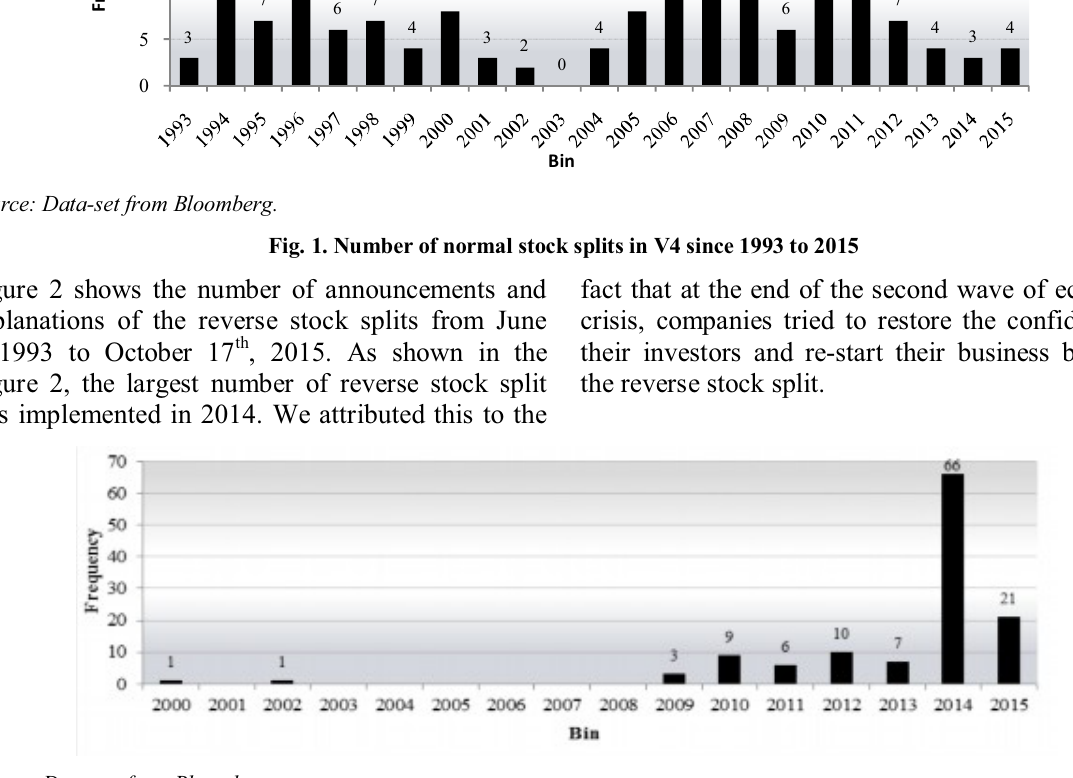
Fig. 2. Number of reverse stock splits in V4 since 1993 to